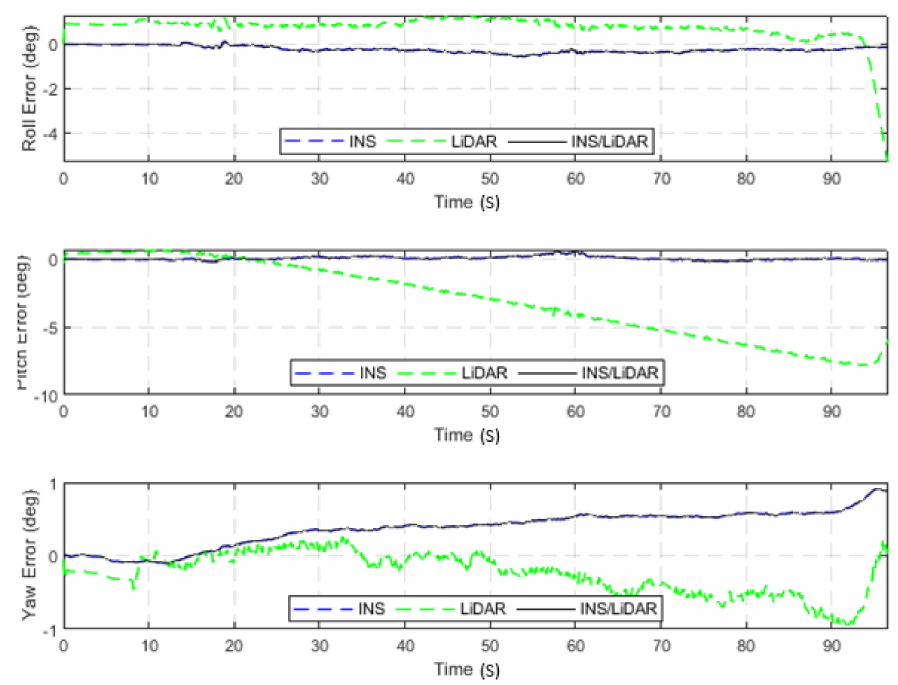
Figure 14. D-101—complete GNNS signal outage: errors of attitude angles (roll, pitch, and